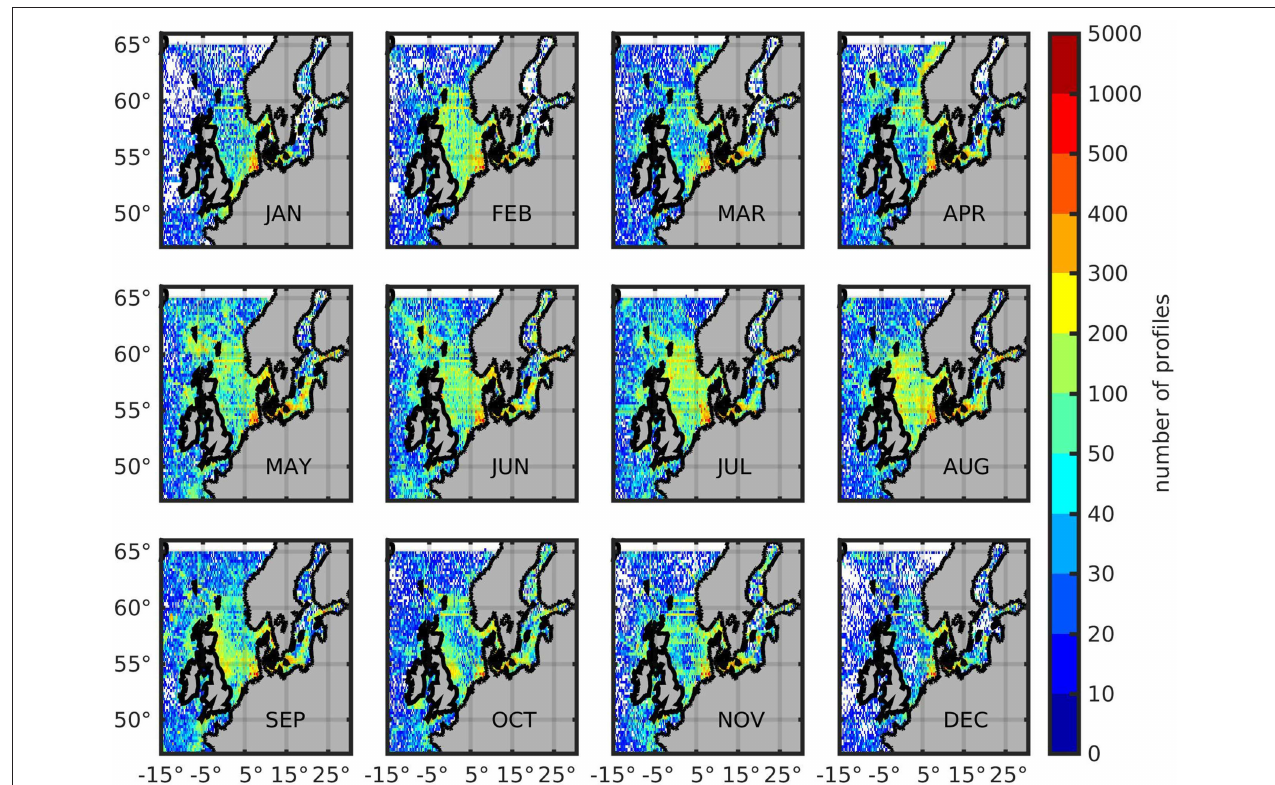
FIGURE 2 | Absolute monthly frequency of marine profiles, 1873–2015, box size 0.25 ◦ × 0.25 ◦ , P = 1,194,475